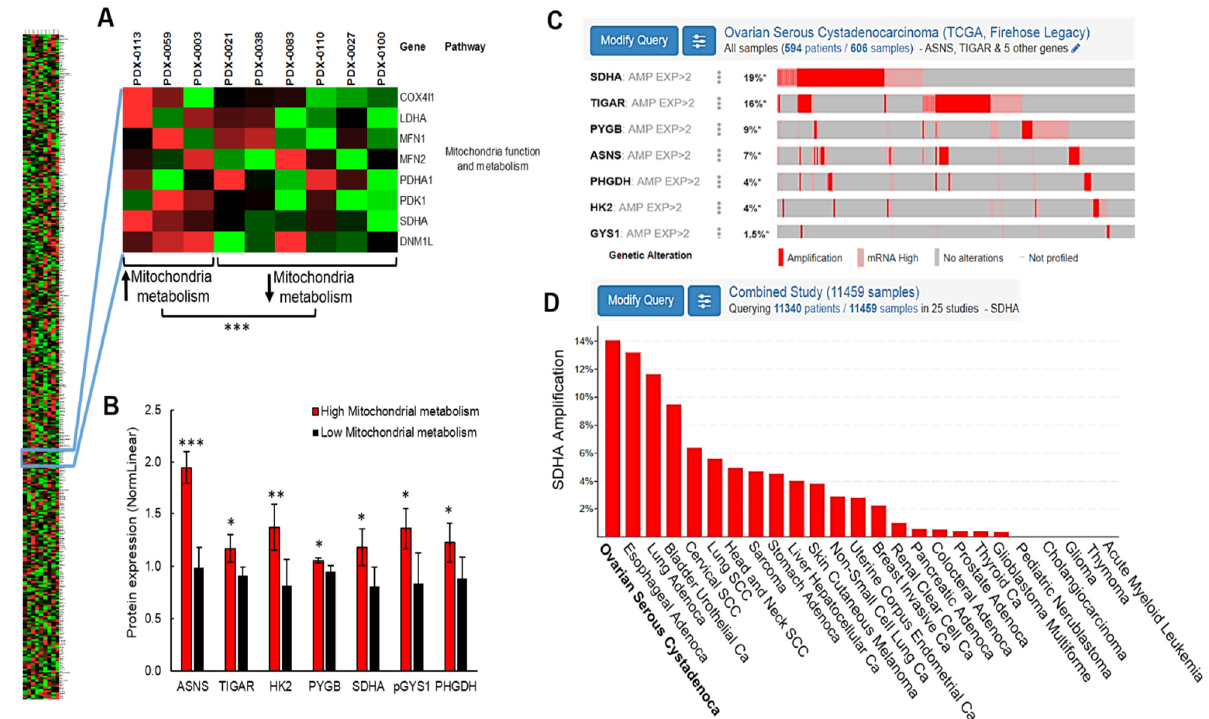
Figure 1. High frequency of SDHA amplification and upregulation in ovarian cancer. ( A ) A heatmap representing the expression of 367 proteins in 9 HGSOC PDX models. Two PDX subsets were identified, one with increased, and the other with decreased expression of proteins associated with mitochondrial function (unpaired t -test). ( B ) The analysis of multiple metabolic pathways in PDX with high vs. low mitochondrial metabolism revealed 7 differentially expressed proteins represented by gene ID. Data are represented as mean ± SD; * = p < 0.05, ** = p < 0.01, and *** = p < 0.001 (multiple t -test). ( C ) In silico TGCA data analysis revealed that amongst 7 differentially expressed proteins between PDX with high vs. low mitochondrial metabolism, SDHA amplification and upregulation was the predominant genetic alteration reaching 19% of HGSOC cases. ( D ) The SDHA amplification occurs with the highest frequency in ovarian carcinoma when compared with 25 other malignancies. For additional information see Supplementary Table S1 and Figure S1.